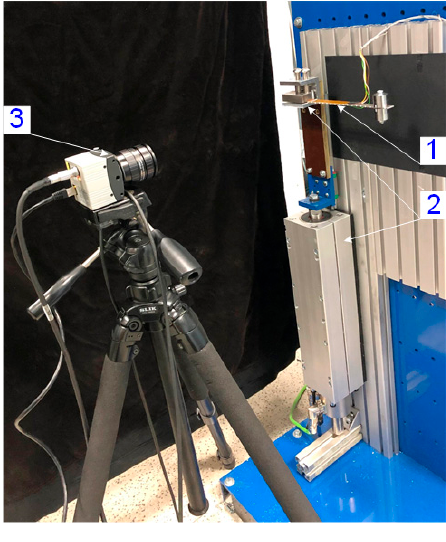
Figure 1. View of the laboratory stand: 1—cantilever piezoelectric beam, 2—vibration-generation system, 3—camera.